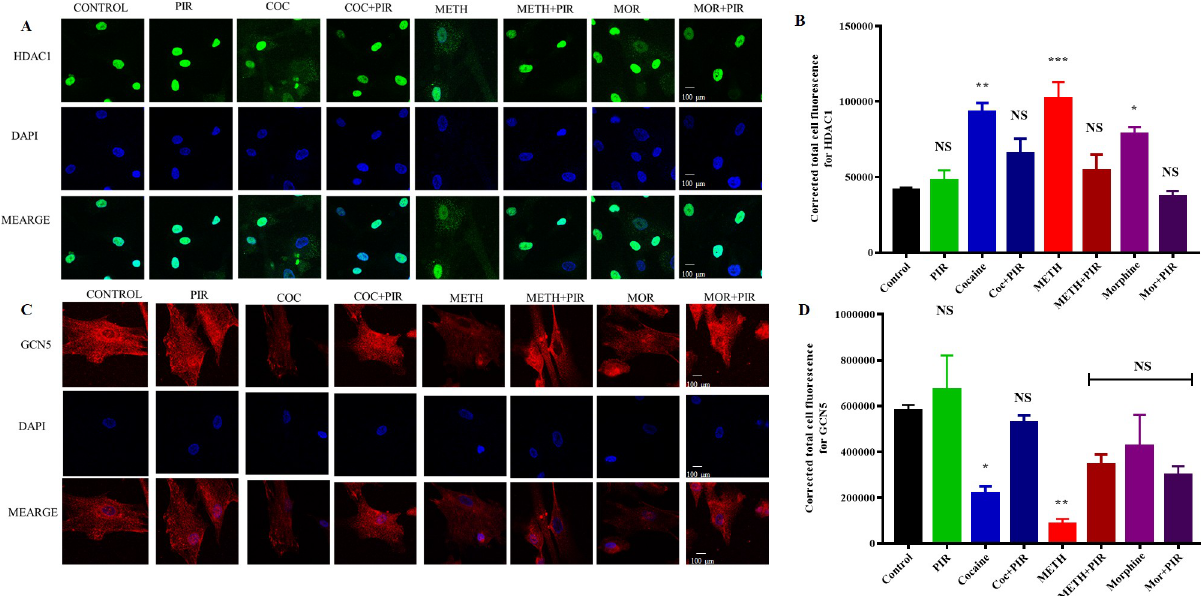
Fig 6. Effects of the psychostimulants cocaine, METH and morphine on the expression and translocation of HDAC1 and GCN5 in human primary astrocytes. Human primary astrocytes were exposed to cocaine (1 μ M), METH (10 μ M) and morphine (5 μ M) either alone or in combination with piracetam (10 μ M) for 24 h. Controls were maintained in drug-free medium (without drug exposure). Representative immunostaining images of (A) HDAC1 expression (red) and nuclear staining with DAPI (blue) obtained by confocal microscopy (magnification 100x, scale bar 100 μ m). (C) GCN5 expression (red) and nuclear staining with DAPI (blue) obtained by confocal microscopy (magnification 100x). The data are expressed as the mean ± standard error mean of the corrected total cell fluorescence (CTCF) of three independent experiments. Representative graphs depicting immunostaining analysis results showing CTCF values for HDAC1 and GCN5 for all groups in B and D, respectively. N = 3. ���� P < 0.0001, ��� P < 0.001, �� P < 0.01, � P < 0.05, NS—nonsignificant.